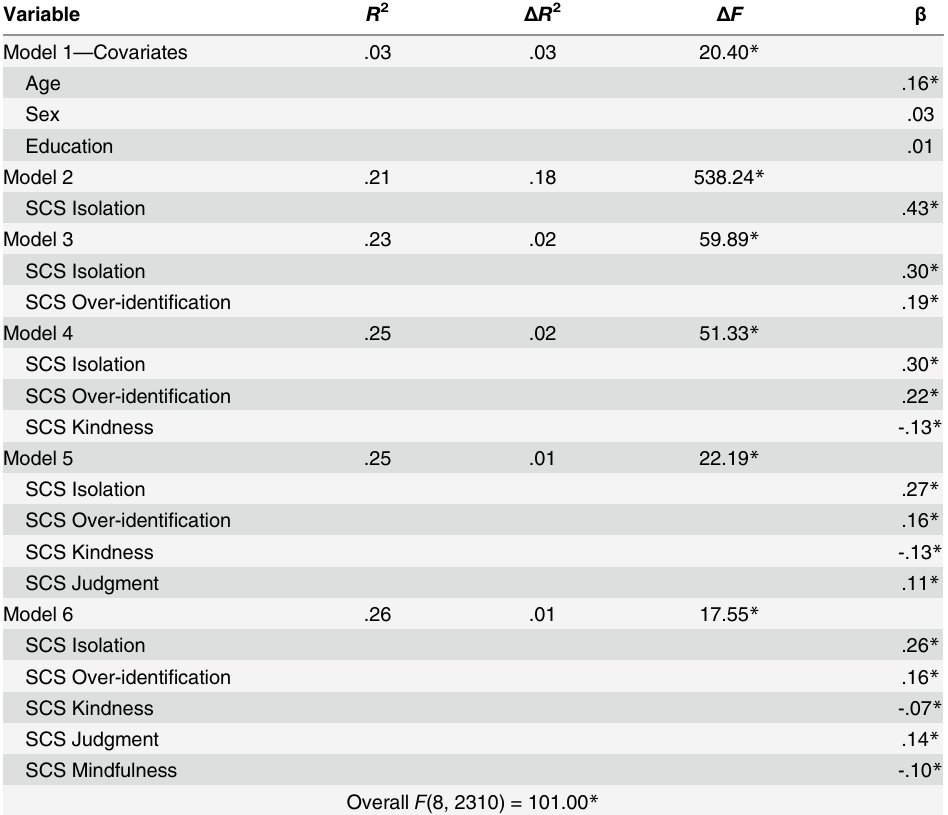
Table 3. Prediction of Depressive Symptomatology (PHQ-9) in the General Population by Self-Com- passion Subscales (n = 2,404).